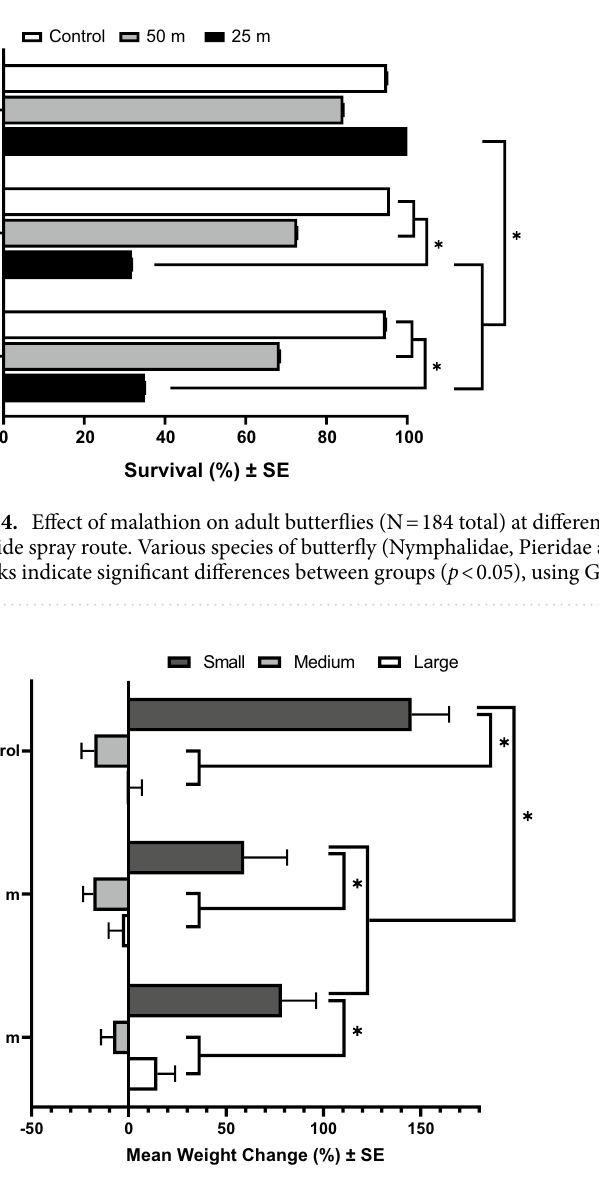
Figure 5. Effect of malathion on development of monarch ( D. plexippus ) caterpillars. Mean mass change of small (N = 87), medium (N = 80), or large-sized (N = 82) monarch caterpillars that fed on host plant leaves treated with malathion over 5 days. Small: < 0.07 g; Medium: 0.07–0.19 g; Large: 0.19–0.9 g. Asterisks indicate significant differences between groups ( p < 0.05), using “indicate